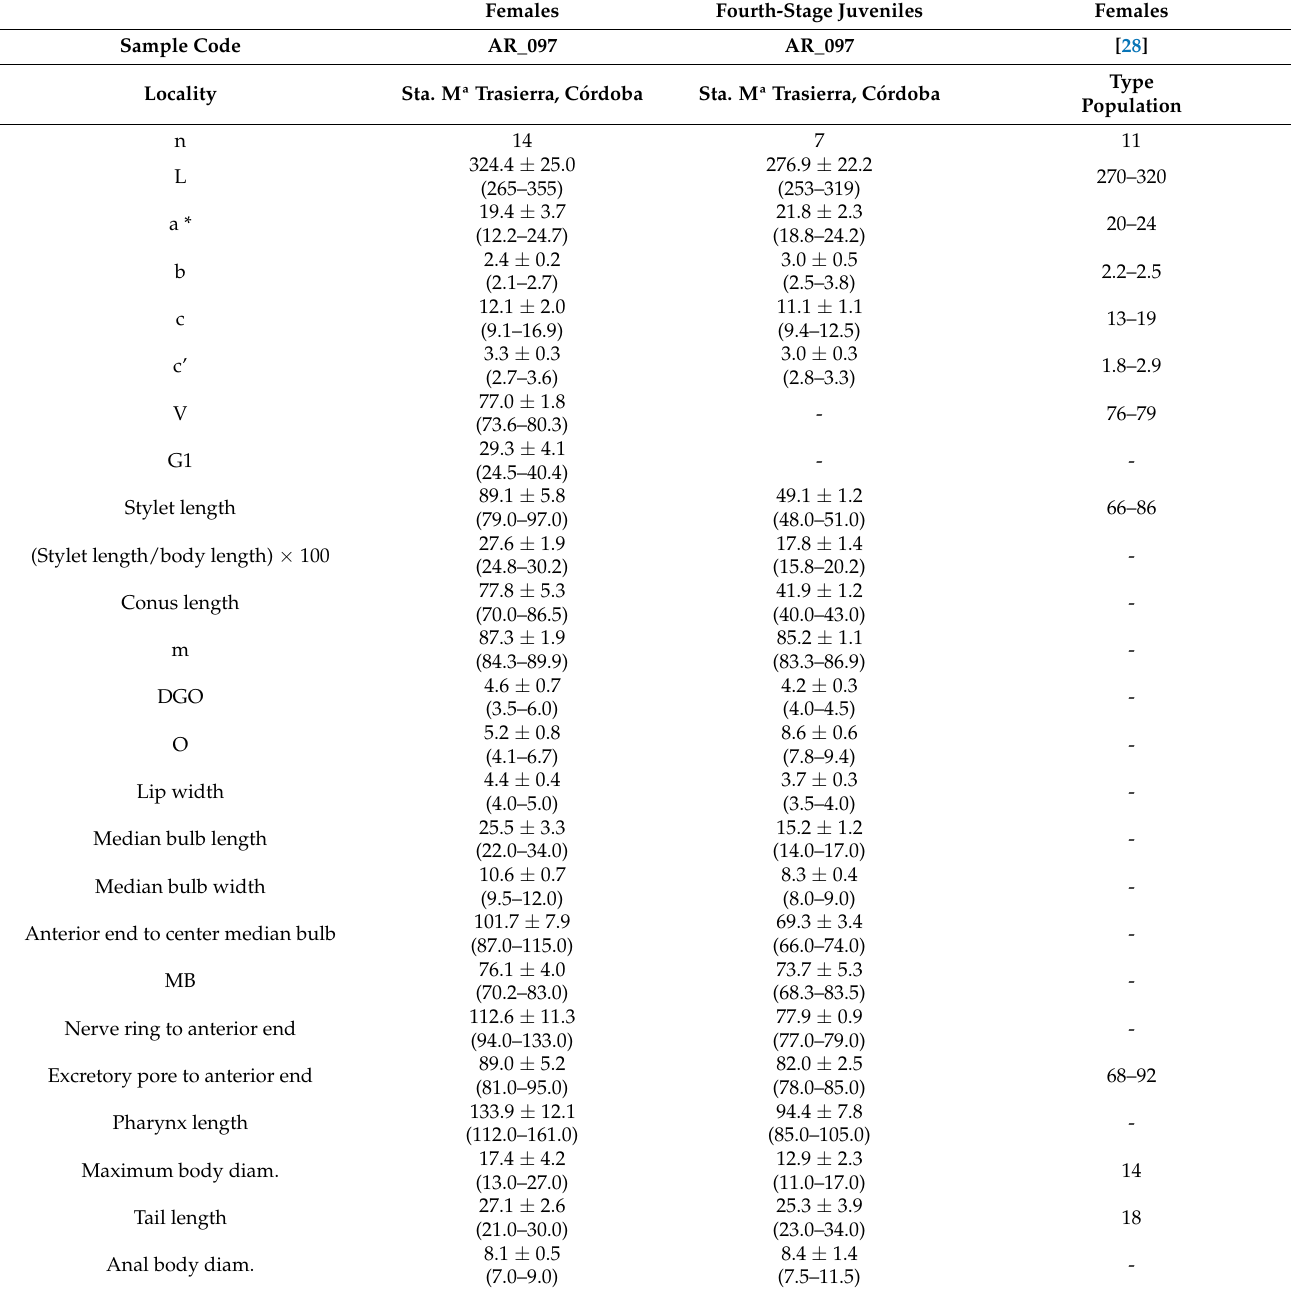
Table 12. Morphometrics of Paratylenchus verus (Brzeski, 1995) Brzeski, 1998 from Santa Mar í a de Trasierra, C ó rdoba, Spain. All measurements are in µ m and in the form: mean ± s.d.